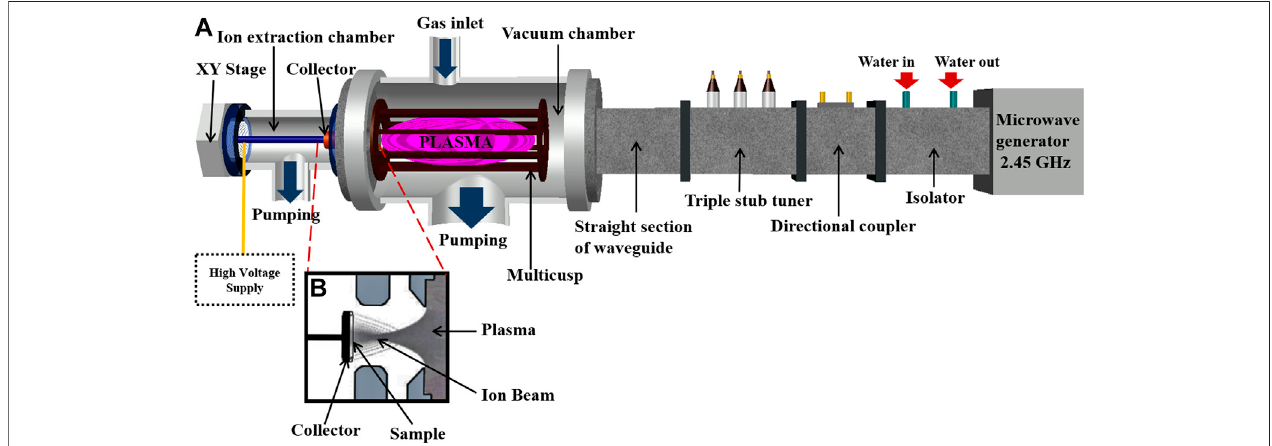
FIGURE 1 | (A) Schematic diagram of experimental setup (not to scale); (B) ion extraction